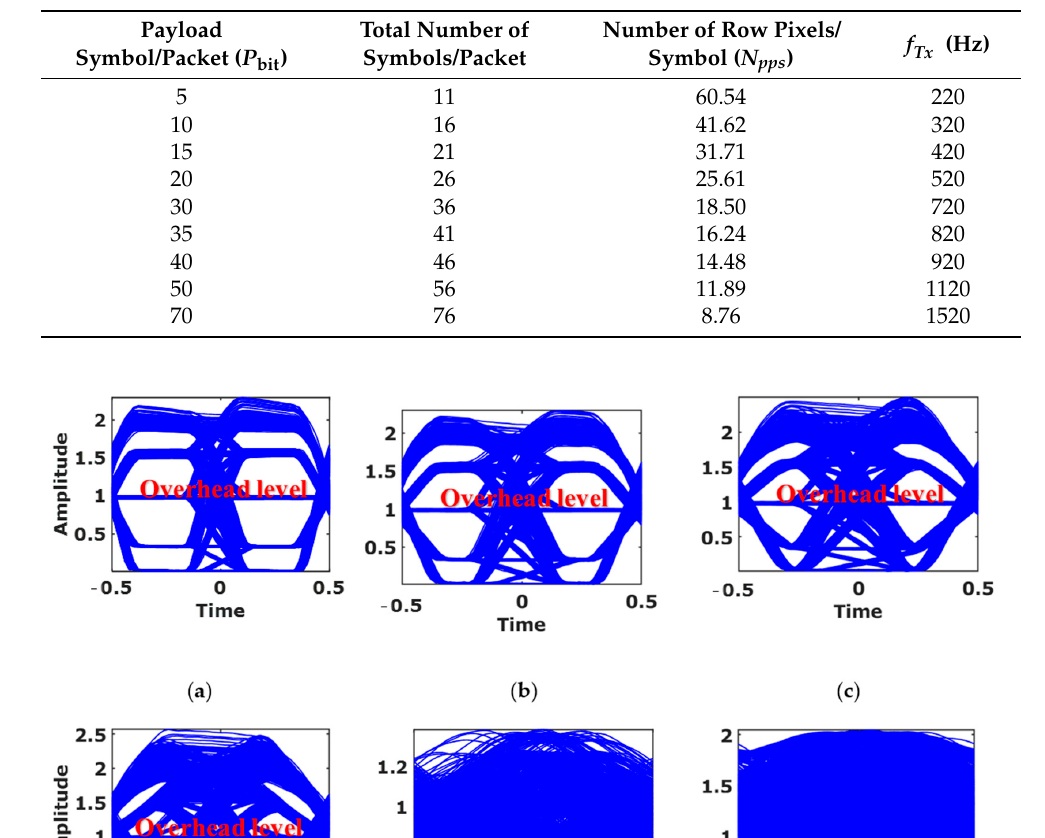
Table 3. Results with R f of 30 fps and CIS width of 1024 px.